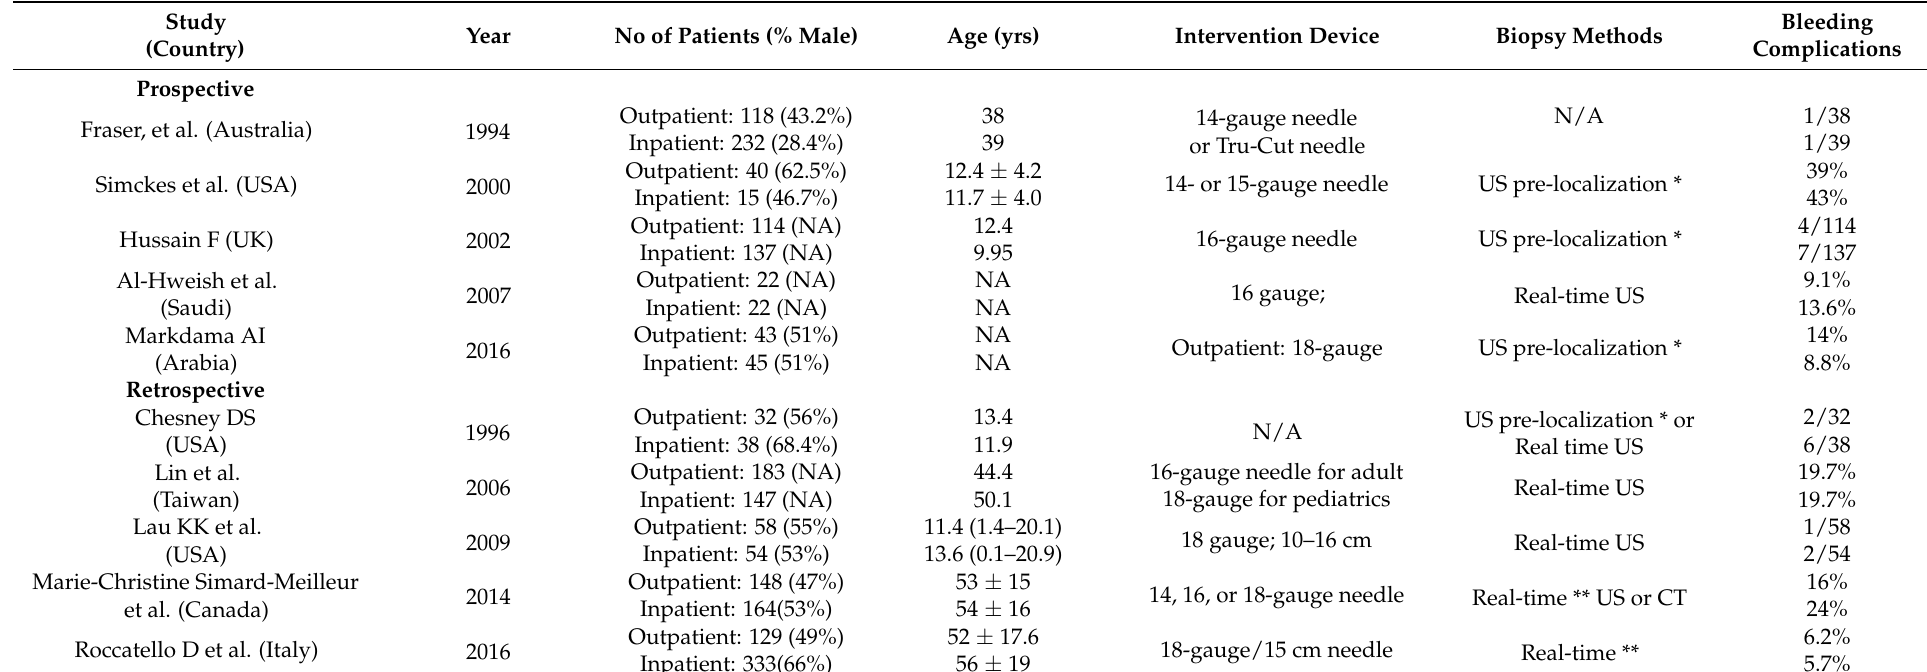
Table 1. Characteristic of